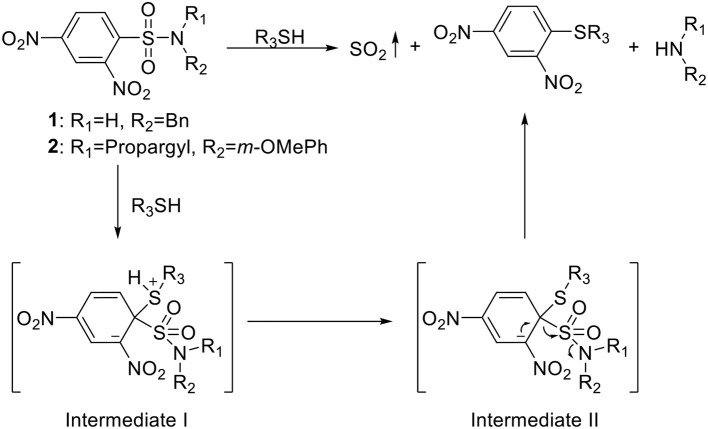
Thiol-activated SO2 prodrugs.